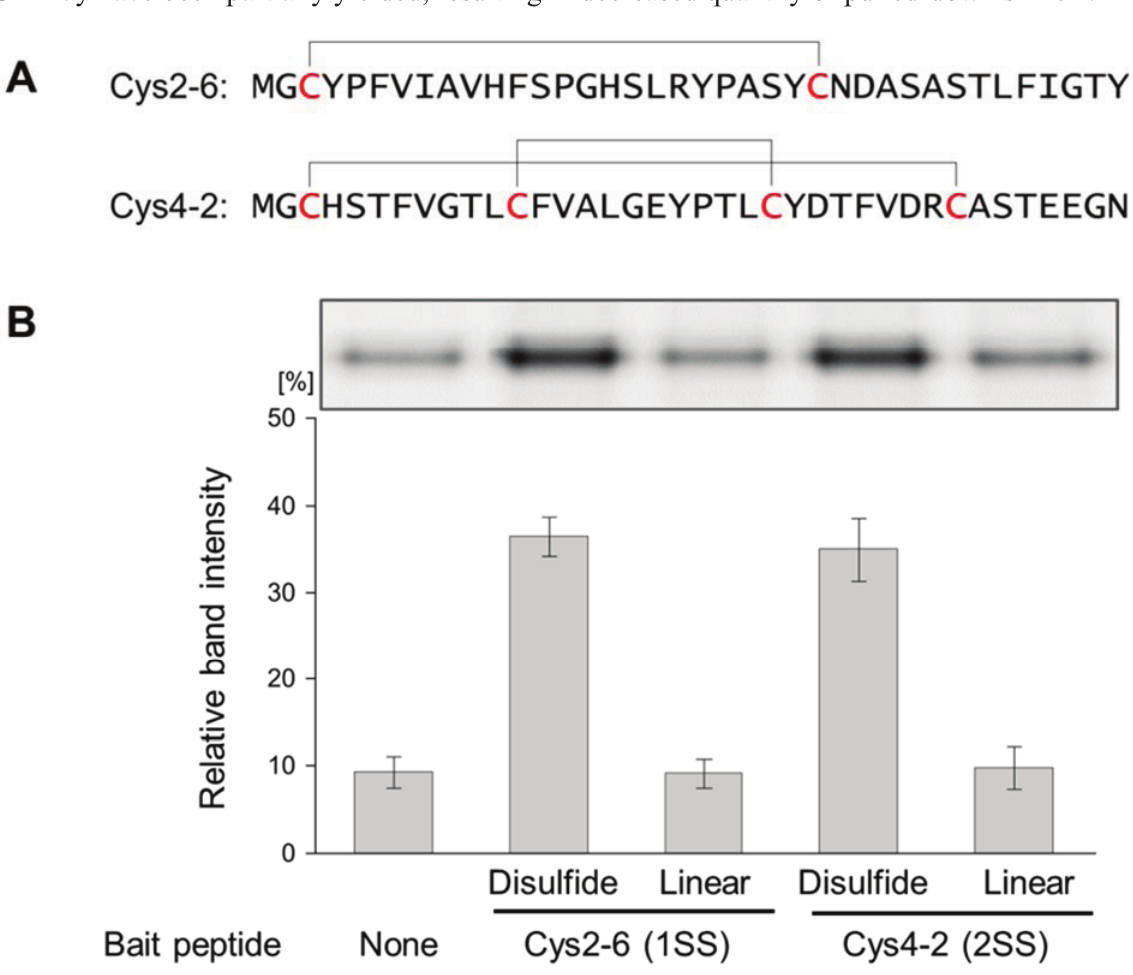
Figure 3. Evaluation of the interaction between the disulfide-containing peptides and sIL-6R by the pull-down method. ( A ) Peptide sequences of Cys2-6 and Cys4-2; ( B ) sIL-6R was pulled down with Cys2-6 (1SS), Cys4-2 (2SS) or the linear forms of each peptide prepared by iodoacetamide treatment (Linear). Magnetic beads with immobilized puromycin-linker only were used as a negative control (None). The pulled-down sIL-6R was visualized by SDS-PAGE (Upper), and the relative band intensities of the pulled-down sIL-6R were measured using analysis software (Lower). Experiments were repeated 3 times. Error bars = standard